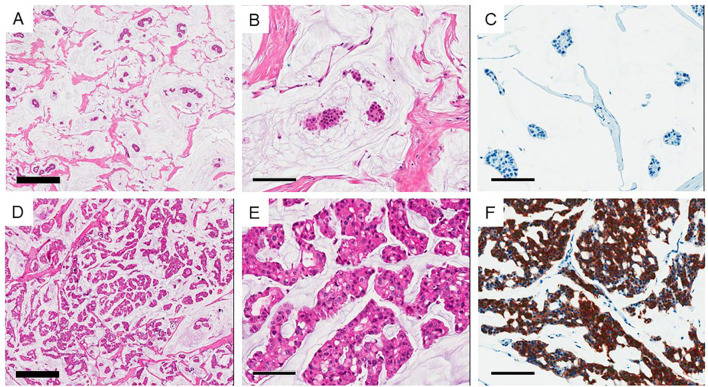
Two subtypes of mucinous carcinoma. (A–C) Type A (Paucicellular) variant and (D–F) Type B (hypercellular) variant. (B, E) high power view of each variant. (C, F) Show immunohistochemical staining of synaptophysin. Thick bar 500 μm and thin bar 100 μm.